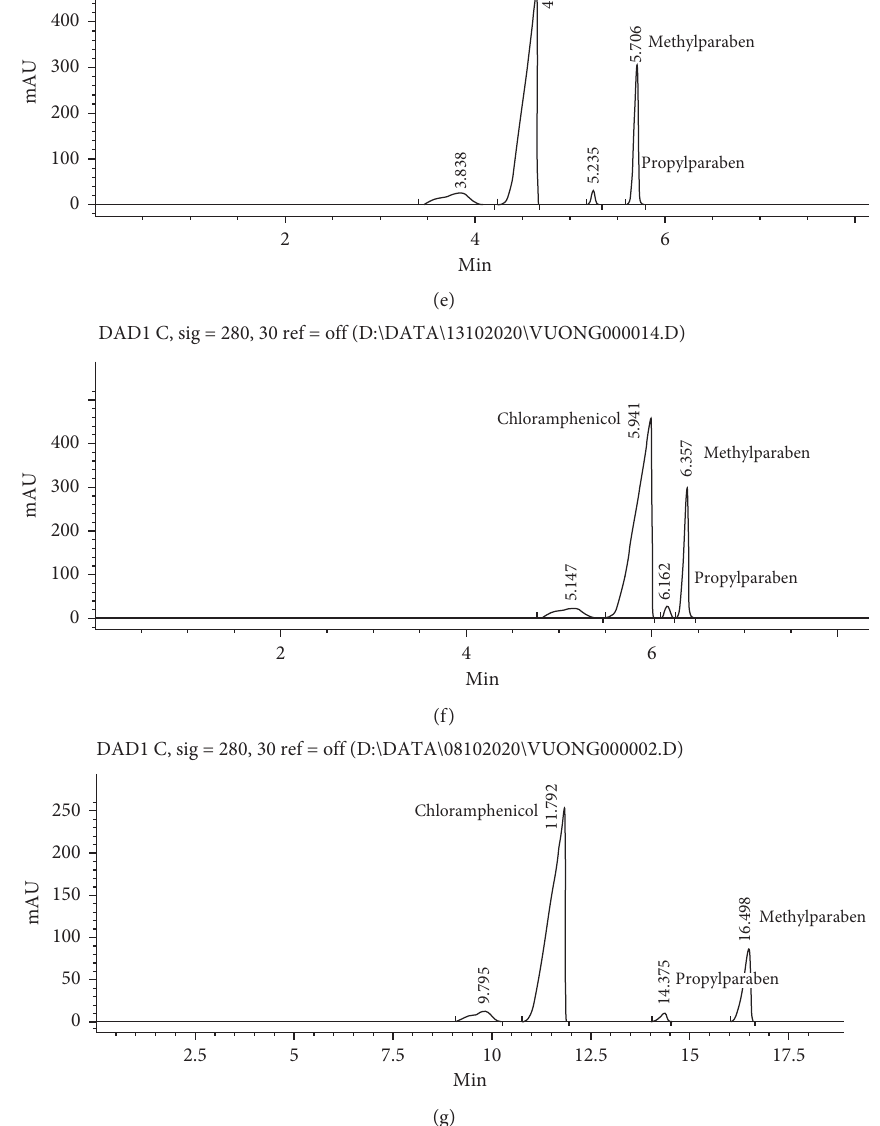
Figure 3: Electropherograms at different concentrations and pHs of sodium tetraborate solution (a):15 mM, pH � 10; (b):15mM, pH � 9.3; (c): 15mM, pH � 8.5; (d): 30 mM, pH � 10; (e): 30mM, pH � 9.3; (f): 30 mM, pH � 8.5; and (g): 40mM, pH �